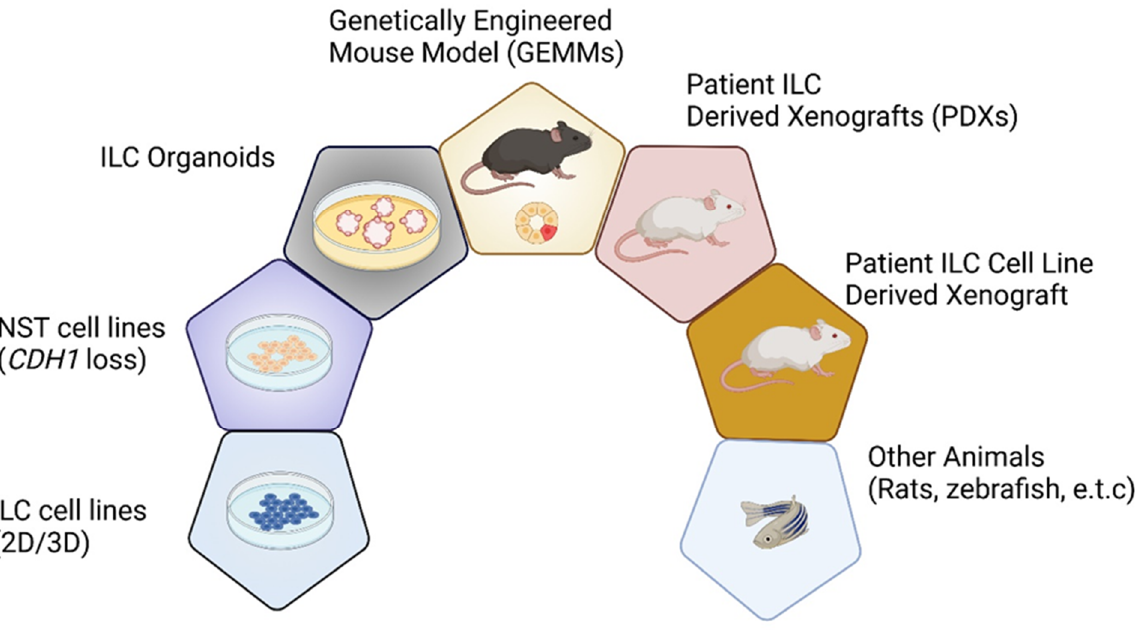
Figure 1. Overview of ILC model systems. Schematic representation of seven key experimental models used for ILC research. Abbreviations: NST, no special type; GEMMs, genetically engineered mouse models; ILC, invasive lobular carcinoma; PDXs, patient-derived xenografts; 2D, two-dimensional; 3D, three-dimensional.